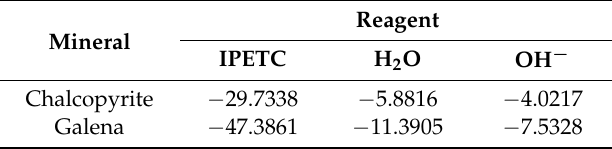
Figure 7. The crystal structure of galena ( a ) and chalcopyrite ( b ). Table 1. The interaction energy (kJ/mol) of reagent and